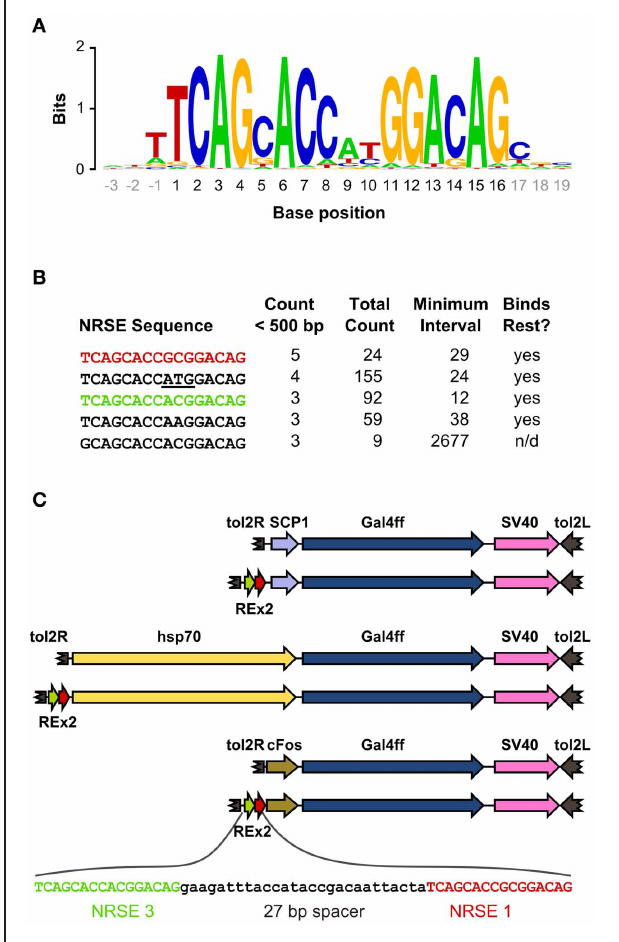
FIGURE 1 | Identification of NRSE sites for testing with basal promoters. (A) Sequence logo representing the consensus zebrafish NRSE sequence. Base positions are relative to the core 16bp element (black). Stack height at each position indicates the degree of conservation and letter height shows relative frequency. (B) Zebrafish NRSE sequences ranked by the number of instances where they are less than 500bp from the transcription start site (Count < 500bp). Also shown for each: the total number of instances of each sequence in the genome, the minimum interval from a sequence to its neighboring NRSE and whether evidence has been reported for rest binding [taken from (Bruce et al., 2004), n/d, not determined]. The ATG in the second NRSE is underlined. (C) Schematic of the constructs tested, in order: SCP1:Gal4ff, REx2-SCP1:Gal4ff, hsp70:Gal4ff, REx2-hsp70:Gal4ff, cFos:Gal4ff, REx2-cFos:Gal4ff. The DNA sequence of the REx2 element, containing the third (green) and first (red) NRSE sequences from (B) is expanded. Elements are shown to scale, except that only part of the tol2 arms at either end of the construct are represented (broken brown